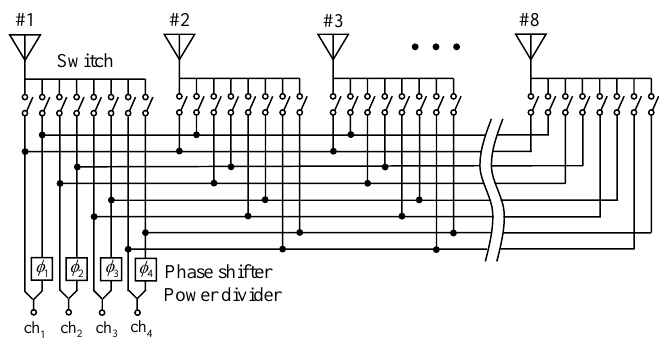
Figure 5. Beam forming network for full-azimuth steering.